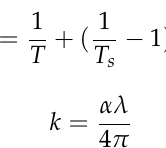
of 80% in the visible region. Moreover, the energy bandgap of the addressed film was calculated according to the Tauc relation